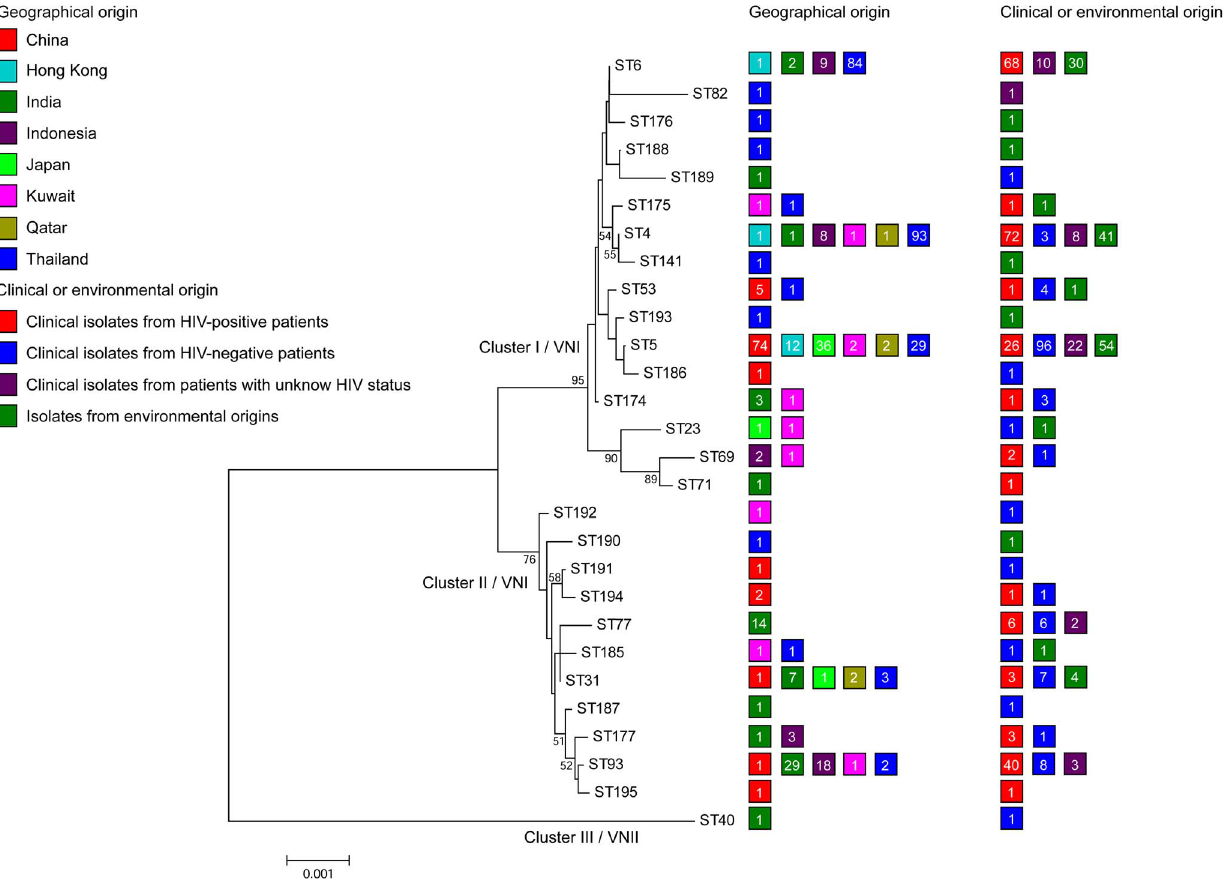
Figure 2. Unrooted Neighbor-joining phylogenetic analysis of the concatenated MLST sequences found among Asian isolates. Numbers at each branch indicate bootstrap values . 50%, based on 1,000 replicates. Each color rectangle represents the origin of isolates according to geographic origin, and clinical and environmental origin. Number inside each color rectangle indicates number of isolates. doi:10.1371/journal.pone.0072222.g002 PLOS ONE |